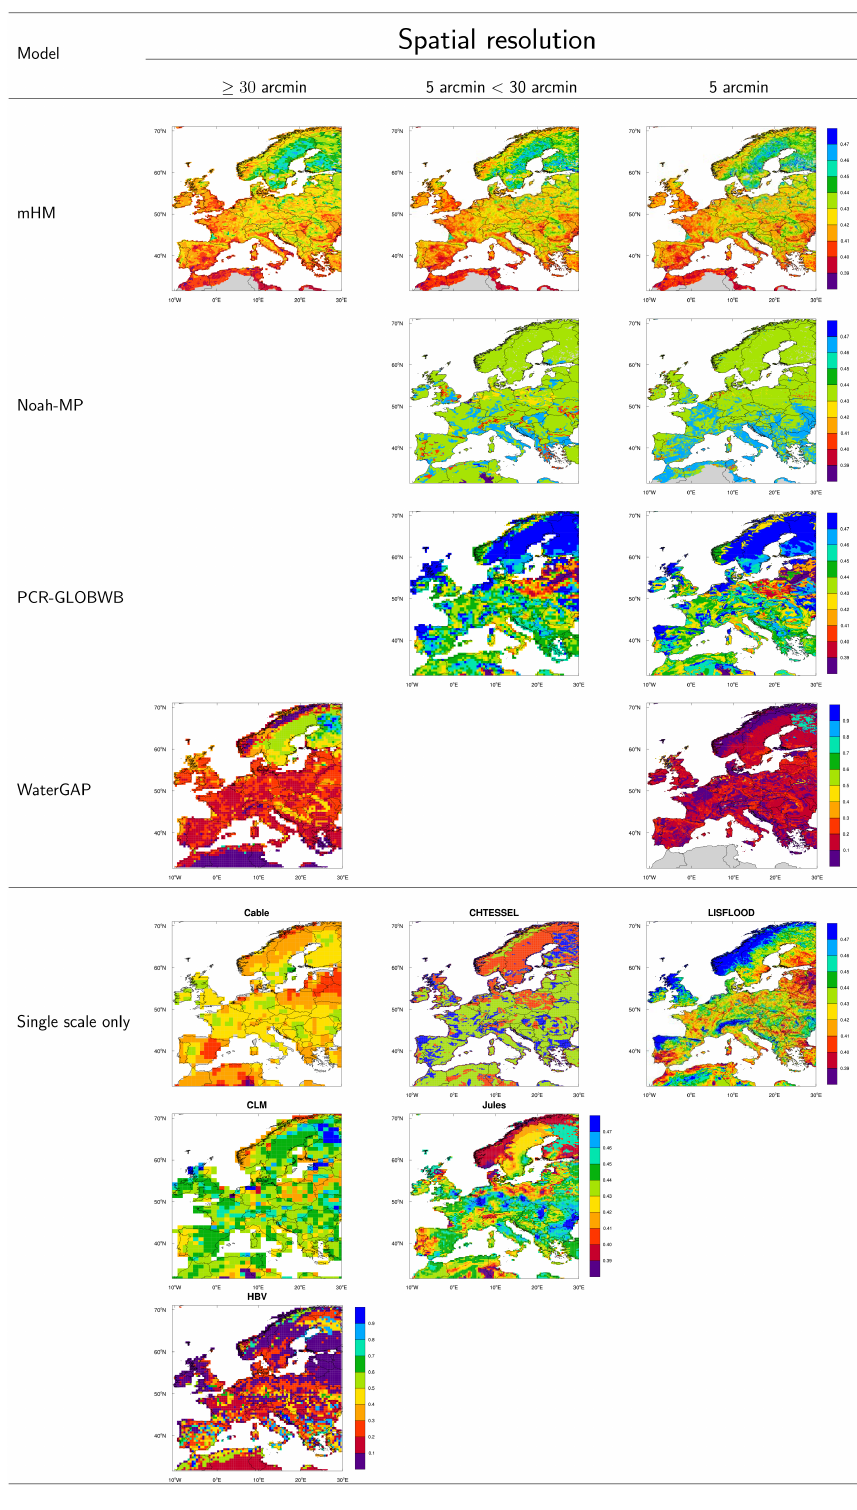
Figure 1. Porosity fields (top 2m) of typical LSM/HM over Pan-EU at various resolutions: CABLE (1 ◦ ), CLM (1 ◦ ), CHTESSEL (0.11 ◦ ), JULES (35km), LISFLOOD (EFAS, 5km), mHM (EDgE-C3S, 5km), Noah-MP (CORDEX-EU, 0.11 ◦ ), and PCR-GLOBWB (EDgE-C3S, 5km). Normalized available water capacity of WaterGAP2 (HyperHydro, 30arcmin), [3, 536]mm, WaterGAP3 (HyperHydro, 5arcmin), [1, 960]mm, and HBV [50, 698]mm. In brackets, the normalization values, denoted as [min, max], are provided only for HBV and